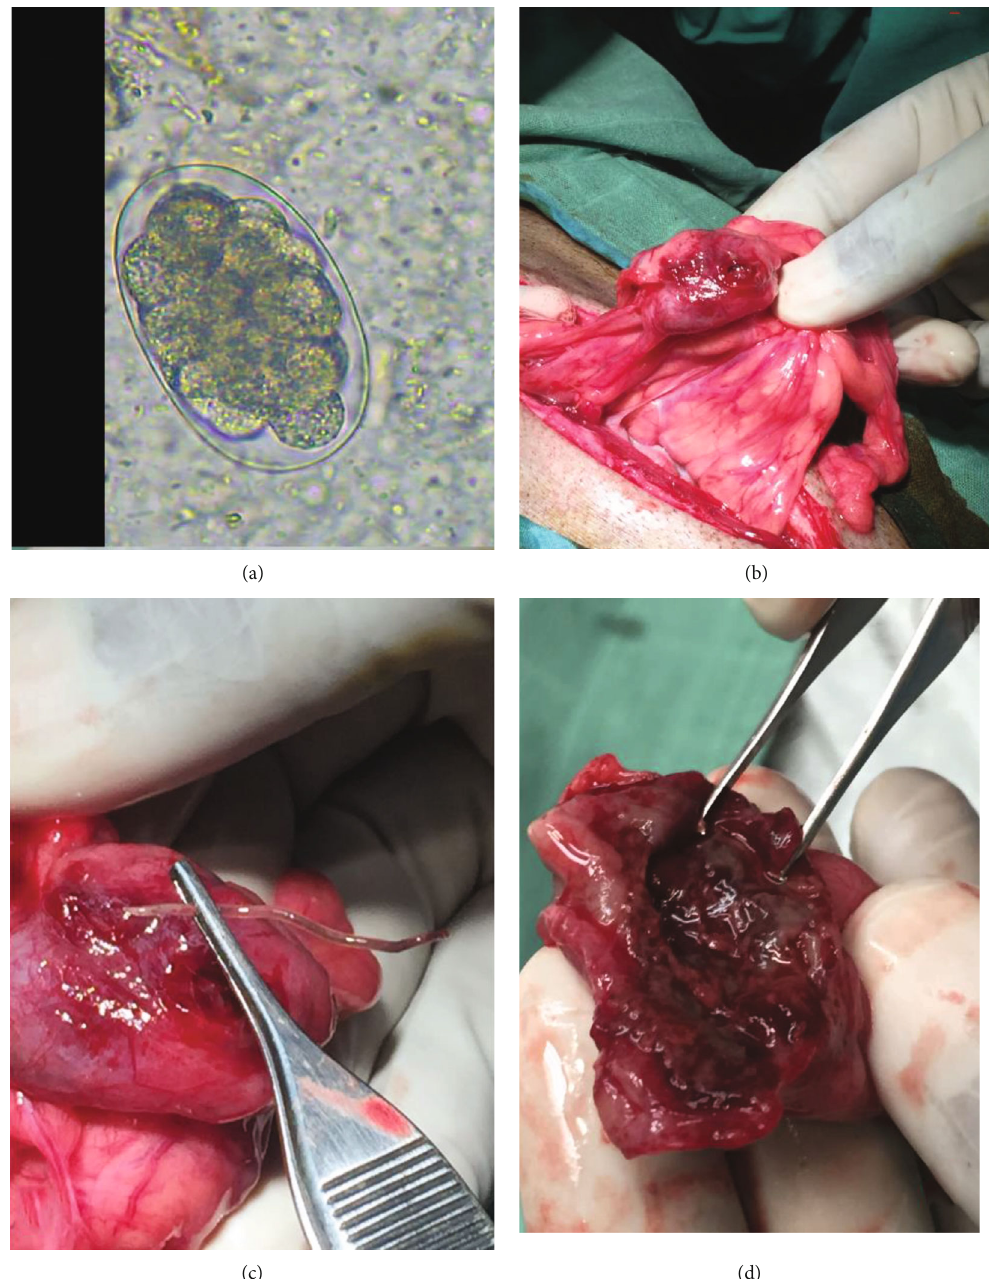
Figure 1: Microscopic image of representative strongylid egg found in feces of Cabinda chimpanzee, of nodules and a worm recovered. (a) Strongylid eggs recovered with the SF-Mc method. (b) Nodules attached on the mesentery. (c) Nodule attached to the descending colon with an adult worm extracted from the nodule. (d) Nodule recovered on the abdominal